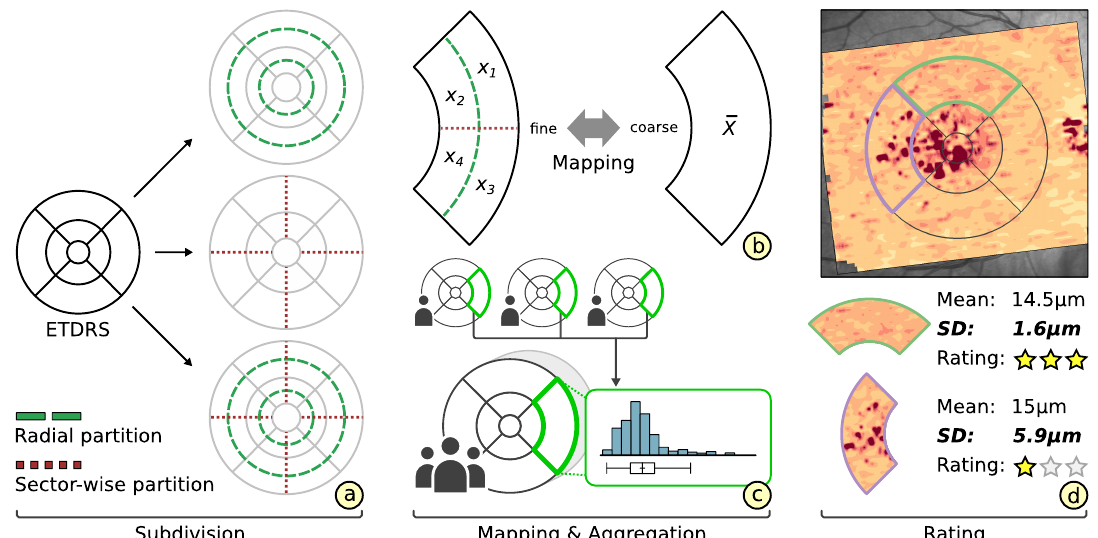
Figure 4. Subdivision, mapping, aggregation, and rating of grids. The standard ETDRS grid layout is subdivided via radial (dashed line) or sector-wise (dotted line) partitions ( a ). A coarse grid is mapped to a fine grid or vice versa by subdividing or merging corresponding grid cells ( b ). Multiple source grids are compiled into a single aggregated grid ( c ). The representation quality of grids is rated by measuring the standard deviation of thickness values within each grid cell ( d